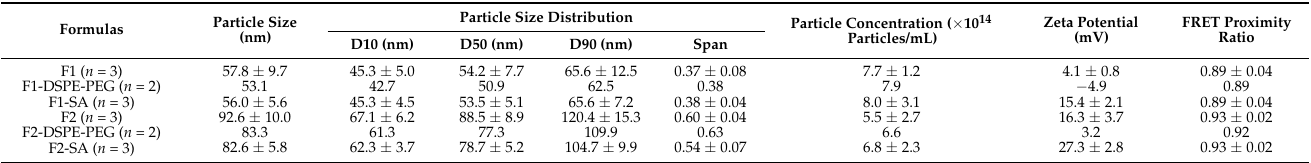
Table 3. Characterization of FRET-LNCs (mean ± SD): particle size, particle size distribution, particle concentration, zeta potential, and proximity